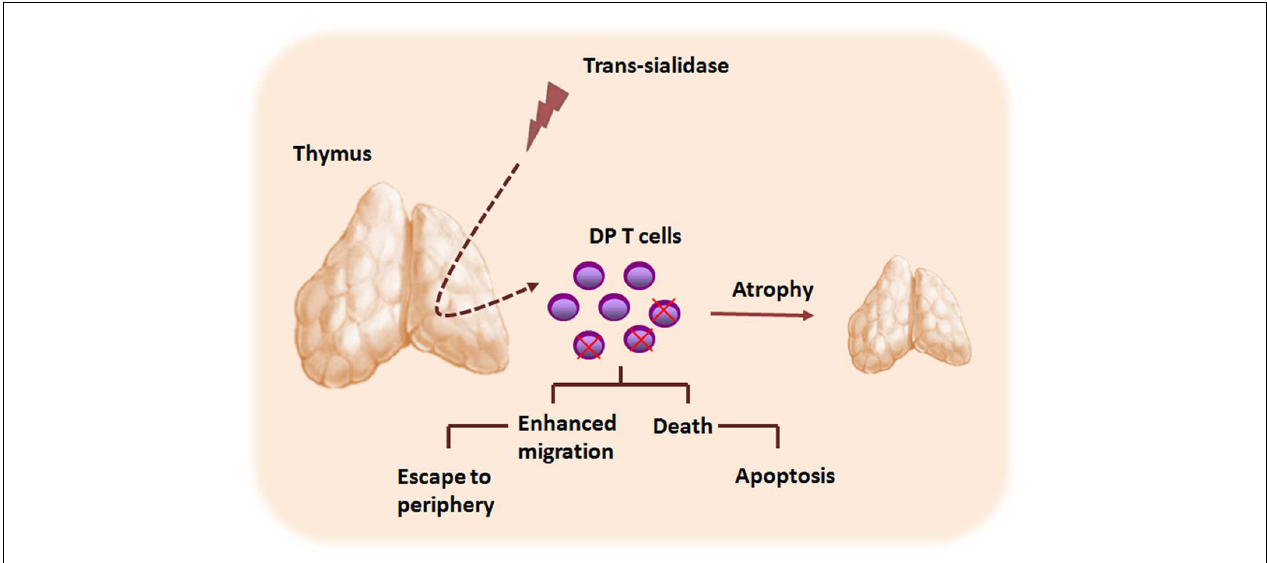
FIGURE 3 | Trypanosoma cruzi TS contributes to the thymic atrophy seen during acute phase of Chagas disease. The thymic atrophy caused by T. cruzi parasite is a complex phenomenon and involves several host–parasite molecule interactions, including those elicited by TS. TS promotes CD4 + CD8 + double positive (DP) cells apoptosis within the thymic nurse cell complex, contributing to the thymic atrophy process. Moreover, TS also modulates the migratory properties of thymocytes, and may contribute to the abnormal release of DP thymocytes to the periphery.